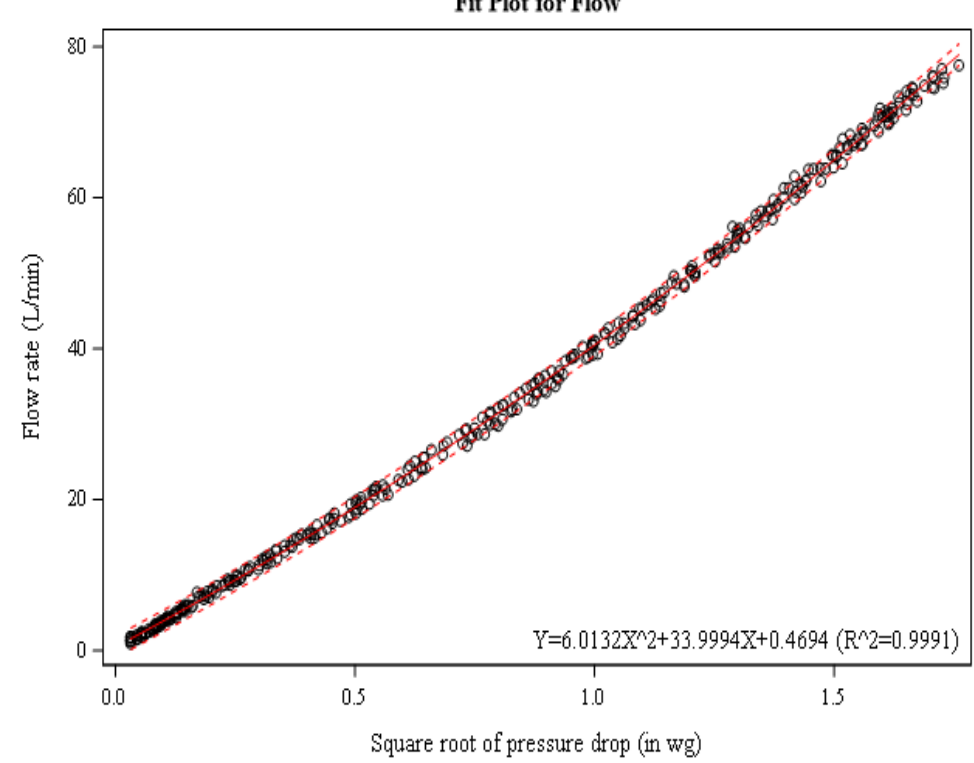
Figure 2. Relationship between square root of pressure drop and flow rate for ten flow cells. Table 1. Volume estimation using topography device with both high- and low-pressure sensors. Simulated puffs conducted manually at low and high flow rates to fixed volume settings on the 3-L calibration